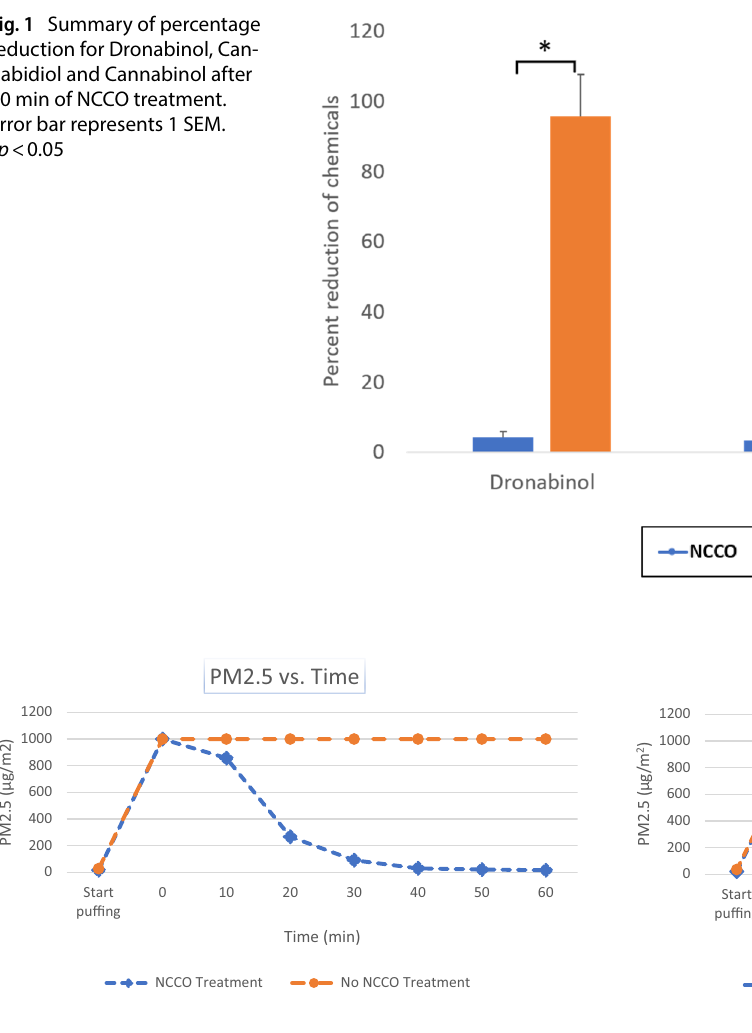
Fig. 2 Particulate matter smaller than 2.5 microns from marijuana smoke